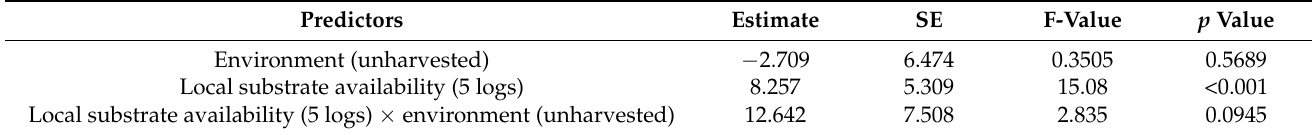
Table 2. Best generalised linear mixed model that predicts the density of males (males per m 2 ) in a log.